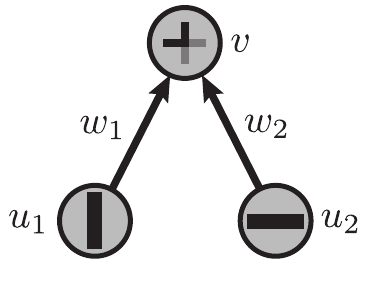
Figure 2: Simple example of a connectionist network with two input neurons u i , i = 1, 2 , and one output neuron v . The strength of the connections are determined by the weight parameters w i